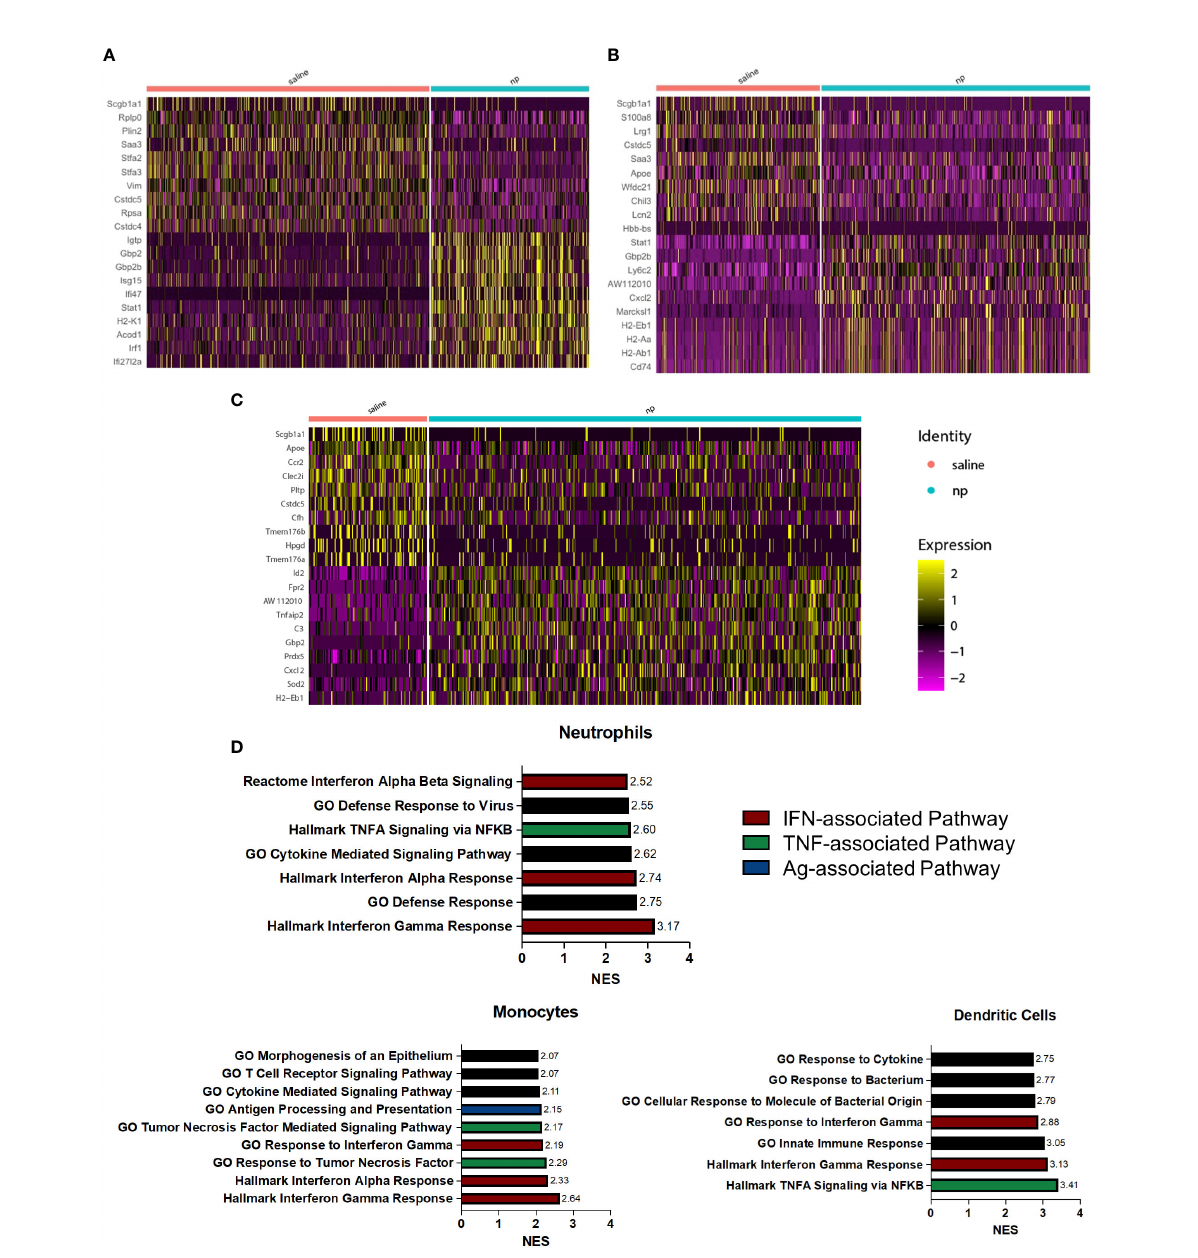
FIGURE 3 NP administration induces in fl ammatory, anti-tumor phenotype among pulmonary myeloid cells in vivo . Heatmap of differentially expressed genes between (A) neutrophils, (B) monocytes, and (C) dendritic cells at the lungs of 4T1-bearing mice receiving NPs or saline. (D) Upregulated pathways among neutrophils, monocytes, and dendritic cells from tumor-bearing mice receiving NPs. Normalized enrichment score (NES) calculated with gene set enrichment